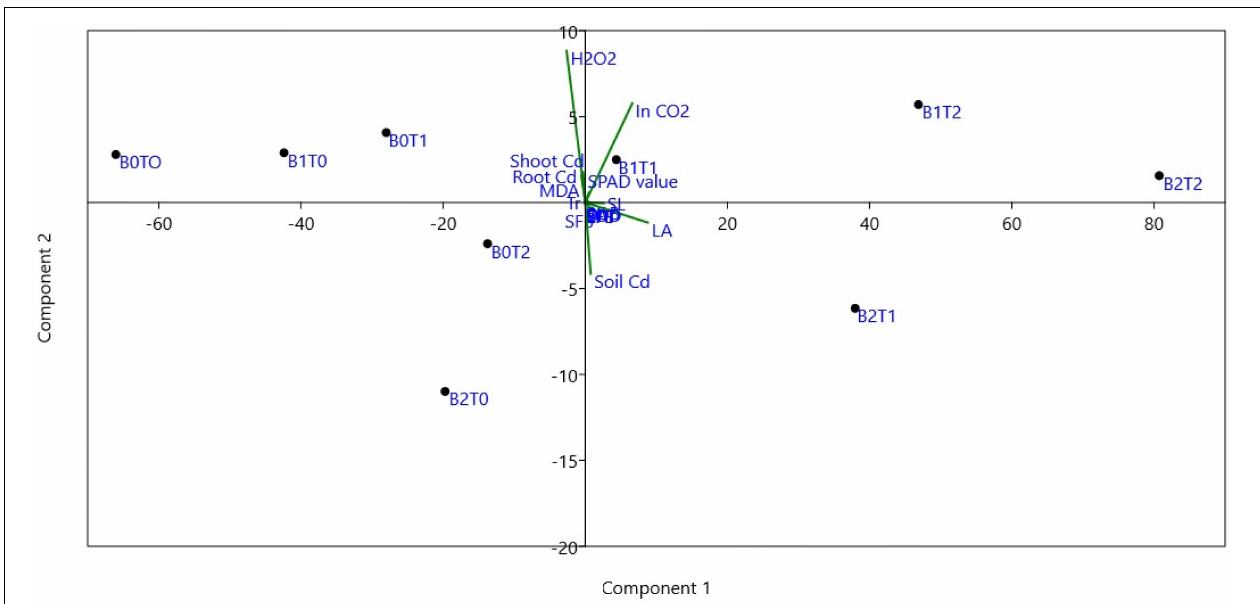
Figure 7 | Principal component analysis (PCA) of all parameters for treatment combination of TU and BC. T 0 = 0 mg L − 1 ; T 1 = 600 mg L − 1 ; T 2 = 600 mg L − 1 ; B 0 = 0% w/w; B 1 = 2.5% w/w; B 2 = 5.0% w/w. BC, biochar; TU, thiourea; RL, total root length; RFB, root fresh biomass; RDB, root dry biomass; SL, shoot length; SFB, shoot fresh biomass; SDB, shoot dry biomass; LAI, leaf area index; SOD, superoxide dismutase in leaves; POD, peroxidase in leaves; CAT, catalase in leaves; EL, electrolyte leakage in leaves; MDA, malondialdehyde; H 2 O 2 , hydrogen peroxide; Ci, intercellular CO 2 concentration; Pn, net photosynthesis rate; Gs, stomatal conductance; Tr, transpiration rate; SPAD, SPAD value; Soil Cd, cadmium concentration in soil; Shoot Cd, cadmium concentration in maize shoot; Root Cd, cadmium concentration in